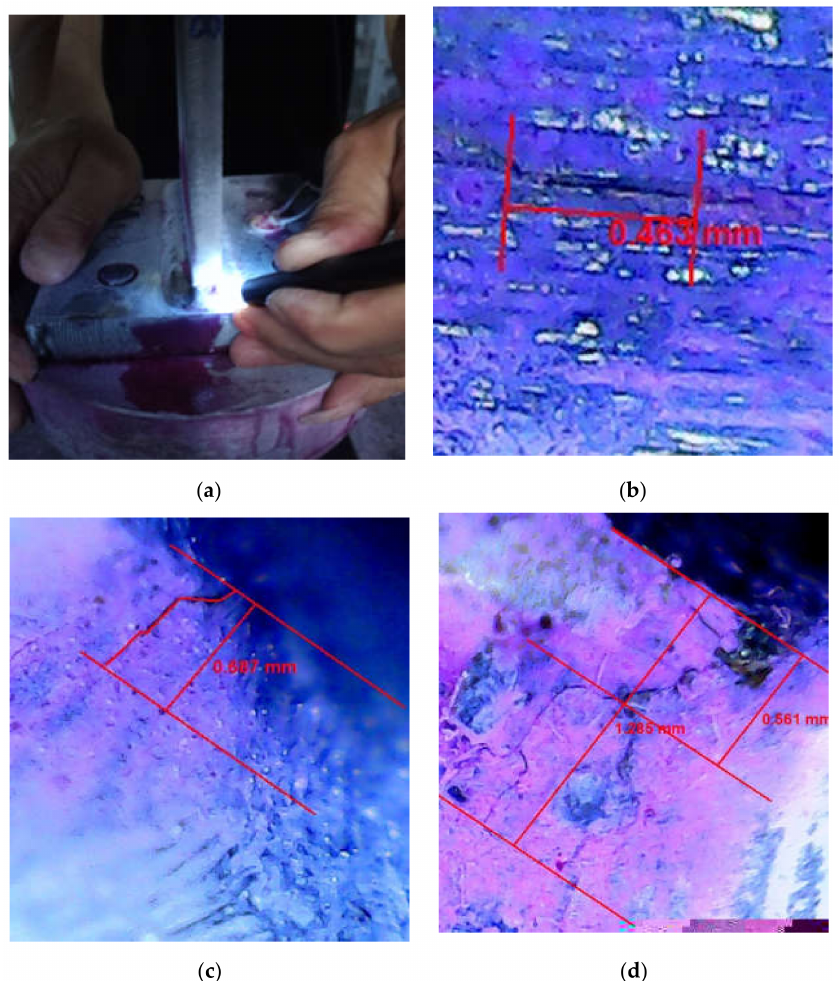
Figure 7. Microscopic observation of fatigue crack in T-type plate joint ( a ) cracks initiated at edges of the base metal ( b ) observed crack of 0.463 mm length ( c ) observed crack of 0.687 mm length ( d ) observed cracks of 0.561 mm and 1.285 mm